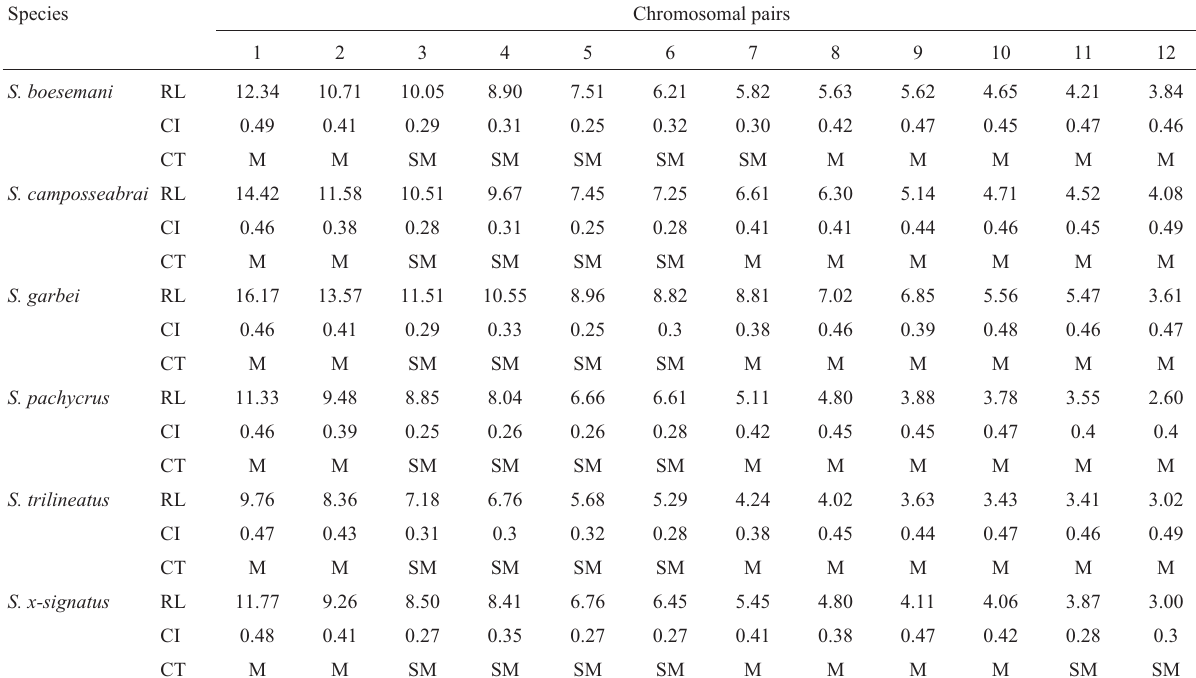
Table2 -Chromosomalmeasurementsofanalyzedspecies(RL-relativelength;CI=centromericindexandCT=chromosomaltype)accordingtoGreen and Sessions (1991).